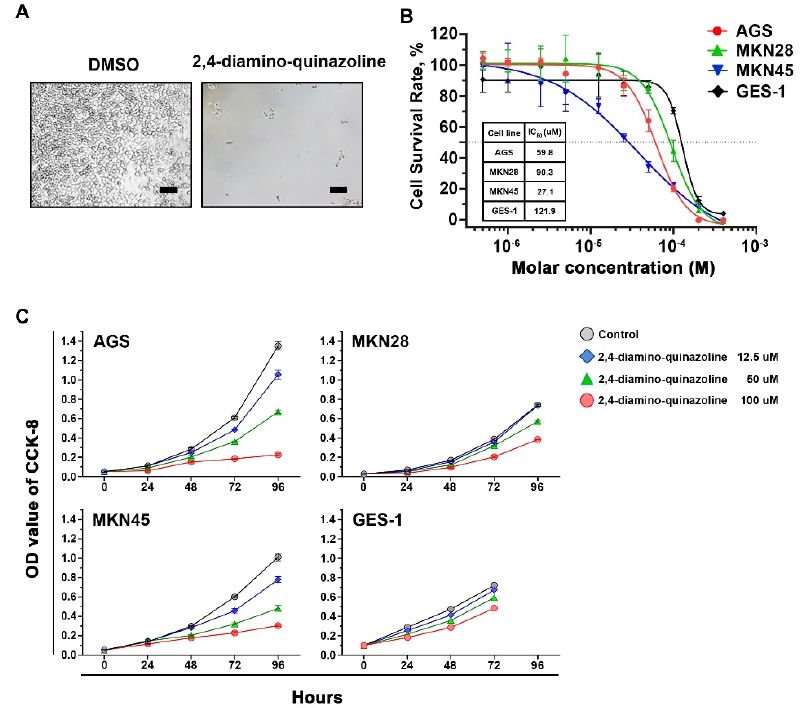
Figure 1. Lymphoid enhancer binding factor 1 ( Lef1 ) is overexpressed in gastric cancer. Scatter dot-plot shows the relative Lef1 expression in 6 normal / gastritis (open circle), 13 early gastric cancer (Stage I & II) and 23 advanced gastric cancer (Stage III & IV) specimens. Data presented as mean with error bars representing SD (** p < 0.01, *** p < 0.001).